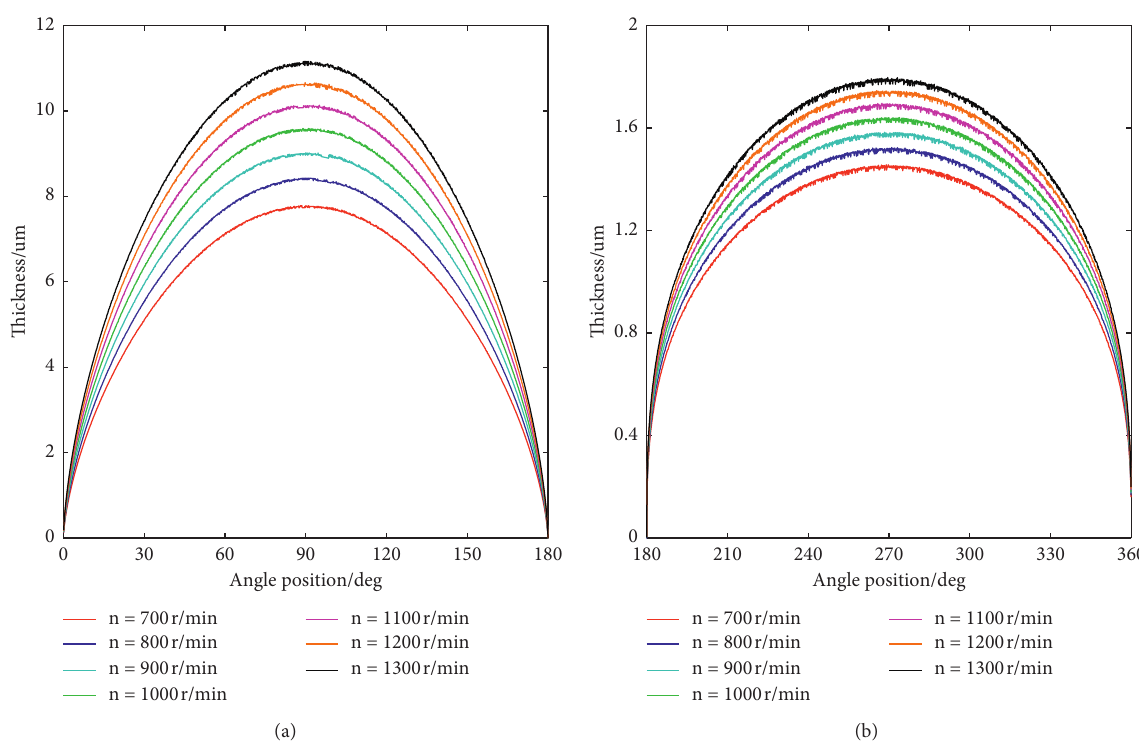
Figure 8: The minimum thickness of PRCB at different speeds. (a) The discharge region; (b) the suction